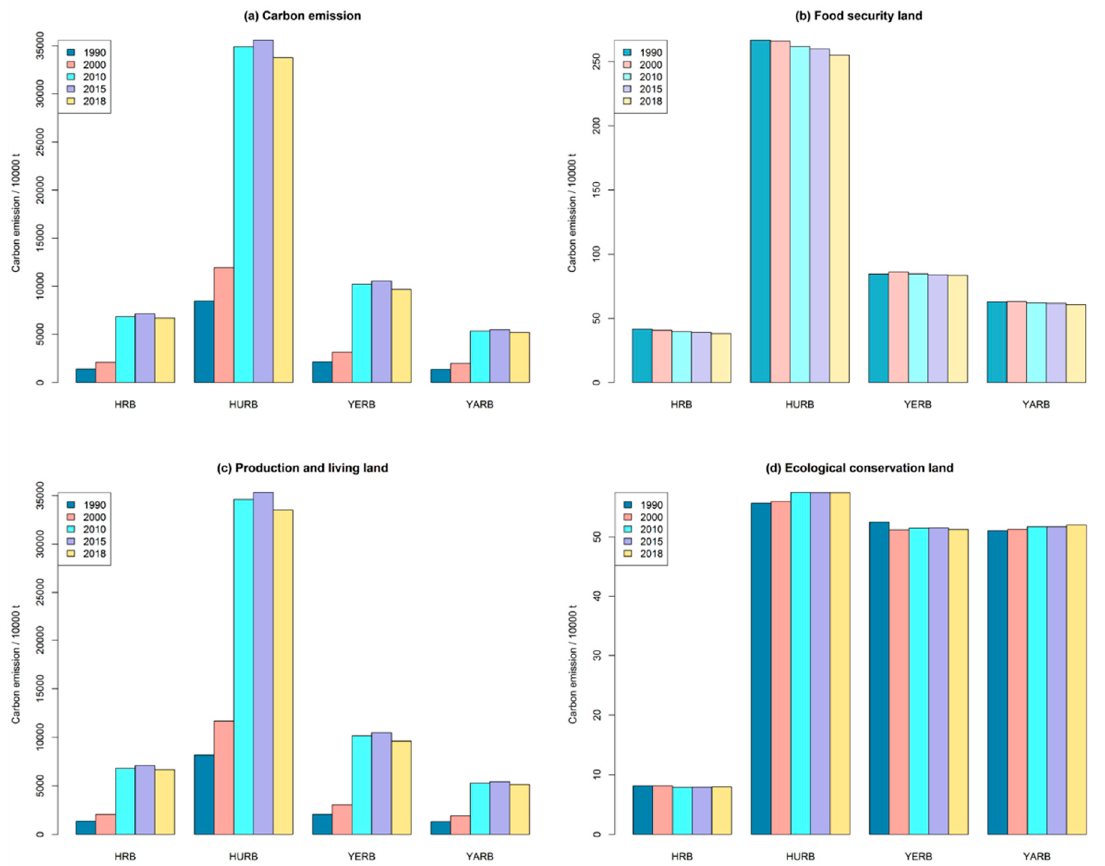
Figure 5. Quantity of carbon storage change in the study area in 1990, 2000, 2010, 2015, and 2018: ( a ) Total quantity of carbon emission; ( b ) Quantity of carbon emission from food security land; ( c ) Quantity of carbon emission from production and living land; ( d ) Quantity of carbon emission from ecological conservation land.